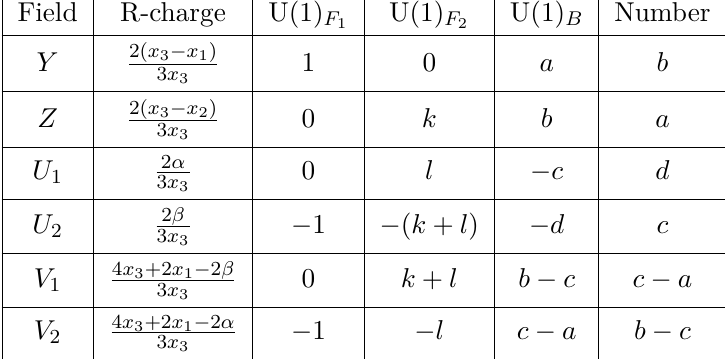
Table 3 . Fields and charges in the L a,b,c